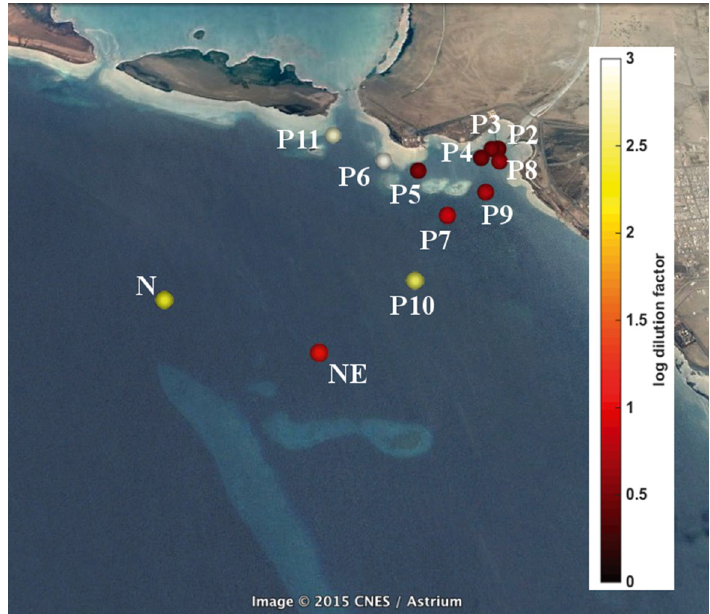
Fig. 6. Median of all monthly log dilution factors (DFs) of the effluent. The lower log DFs (dark red) represent waters with higher plume concentra- tions. DF increases with distance from the outfall as expected, but is still present at Stn N, 4.7 km away, suggesting that the plume from the outfall could have an effect on the submerged reef at Shi’b